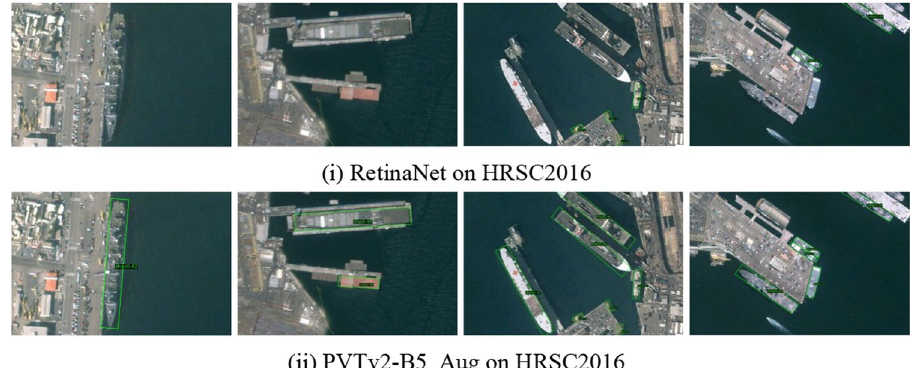
Fig. 8 Effectiveness of PVTv2- B5_Aug on